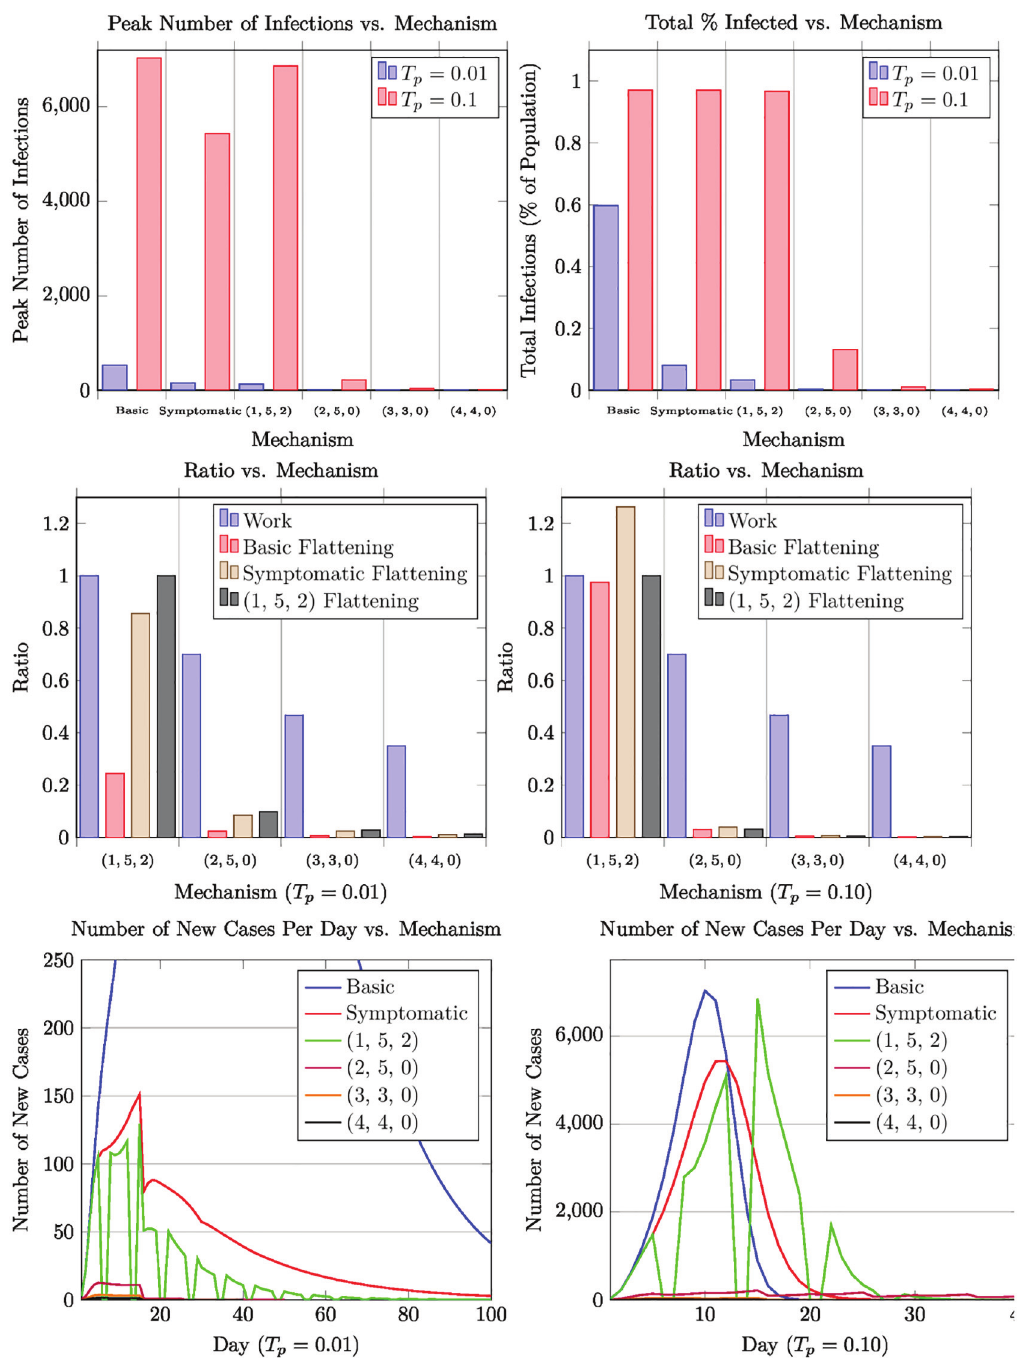
Fig 3. Plots displaying the performance of different mechanisms for the random mixing Model.